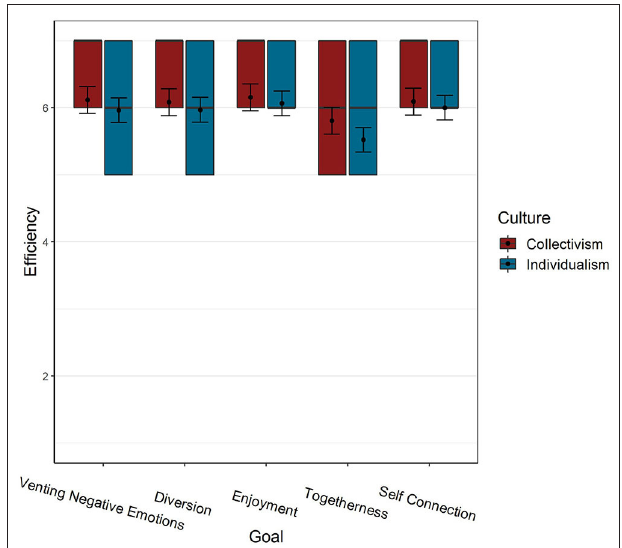
FIGURE 2 | Efficiency of music in obtaining wellbeing goals by culture. Error bars represent 95% CI. Colored squares represent the 2nd and 3rd quartiles of responses. Black lines represent the median, and dots represent the mean.